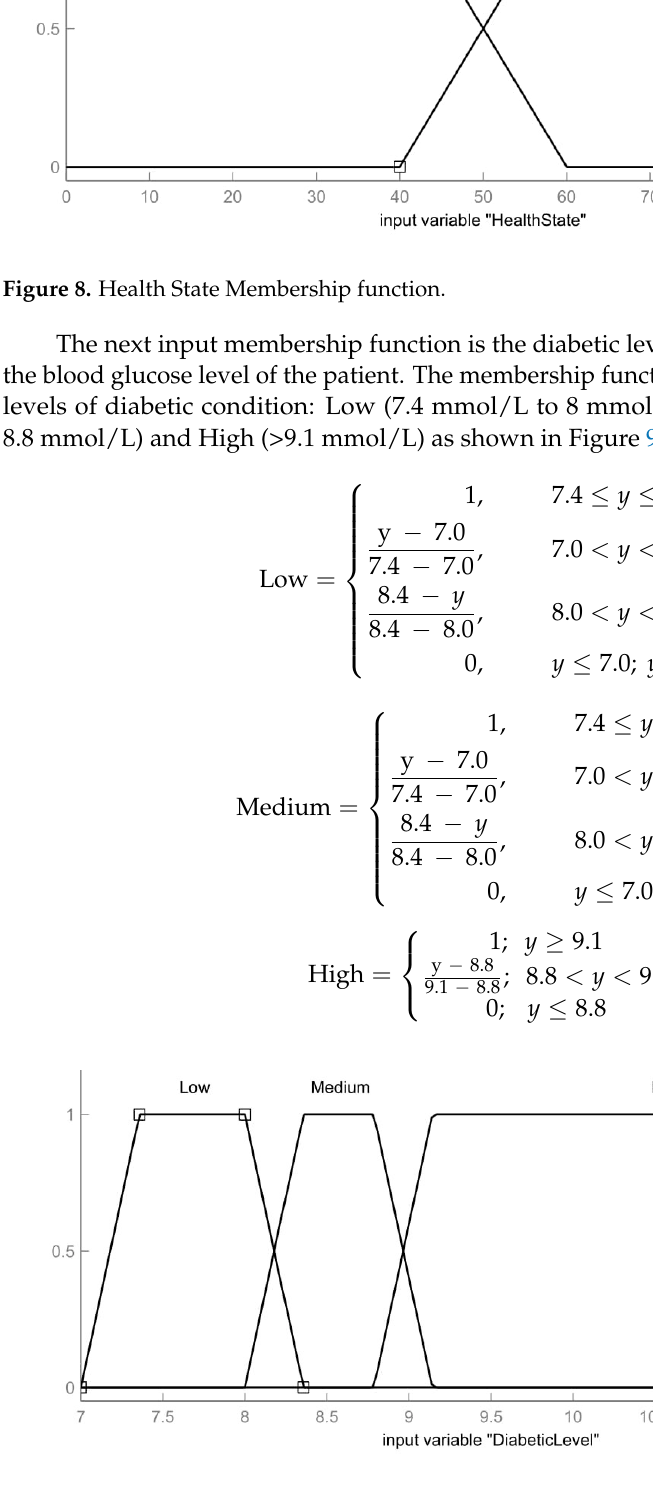
Figure 8. Health State Membership function.